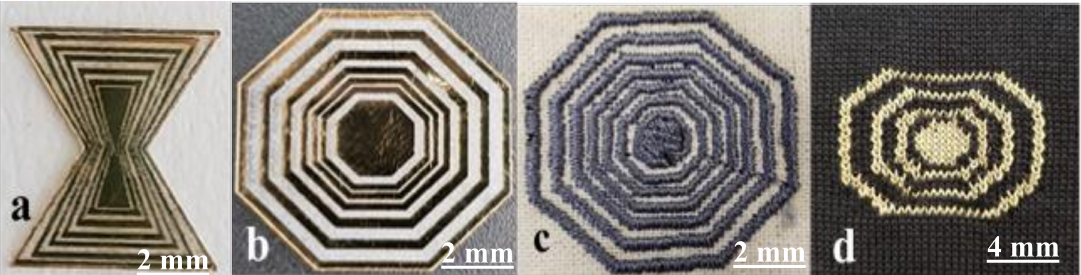
Figure 2. Prototype chipless radio frequency identification (RFID) tags recently developed by our team, ( a , b ) fabricated bow-tie and octagonal chipless RFID tags based on Gold mylar using a laser etching technique, ( c ) embroidered RFID tag using conductive yarn (silver-coated nylon), and ( d ) knitted RFID tag using a conductive yarn and knitting technique [16].